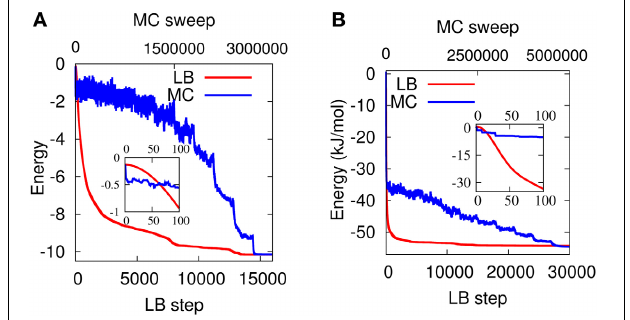
FIGURE 11 | Energy vs. annealing MC sweeps (in blue) and LB steps (in red) for the LBN3d (A) and the LTIP3P (B). Both the MC and the LB methods reach the same minimum for the two potentials. In the case of LTIP3P, the main LB parameters are N = 10 3 , γ = 50 (cid:3) t − 1 , and τ/(cid:3) t = 20 and in the case of LBN3d N = 6 3 , γ = 10 5 (cid:3) t − 1 , and τ/(cid:3) t = 1000. The insets show the very early LB steps/MC